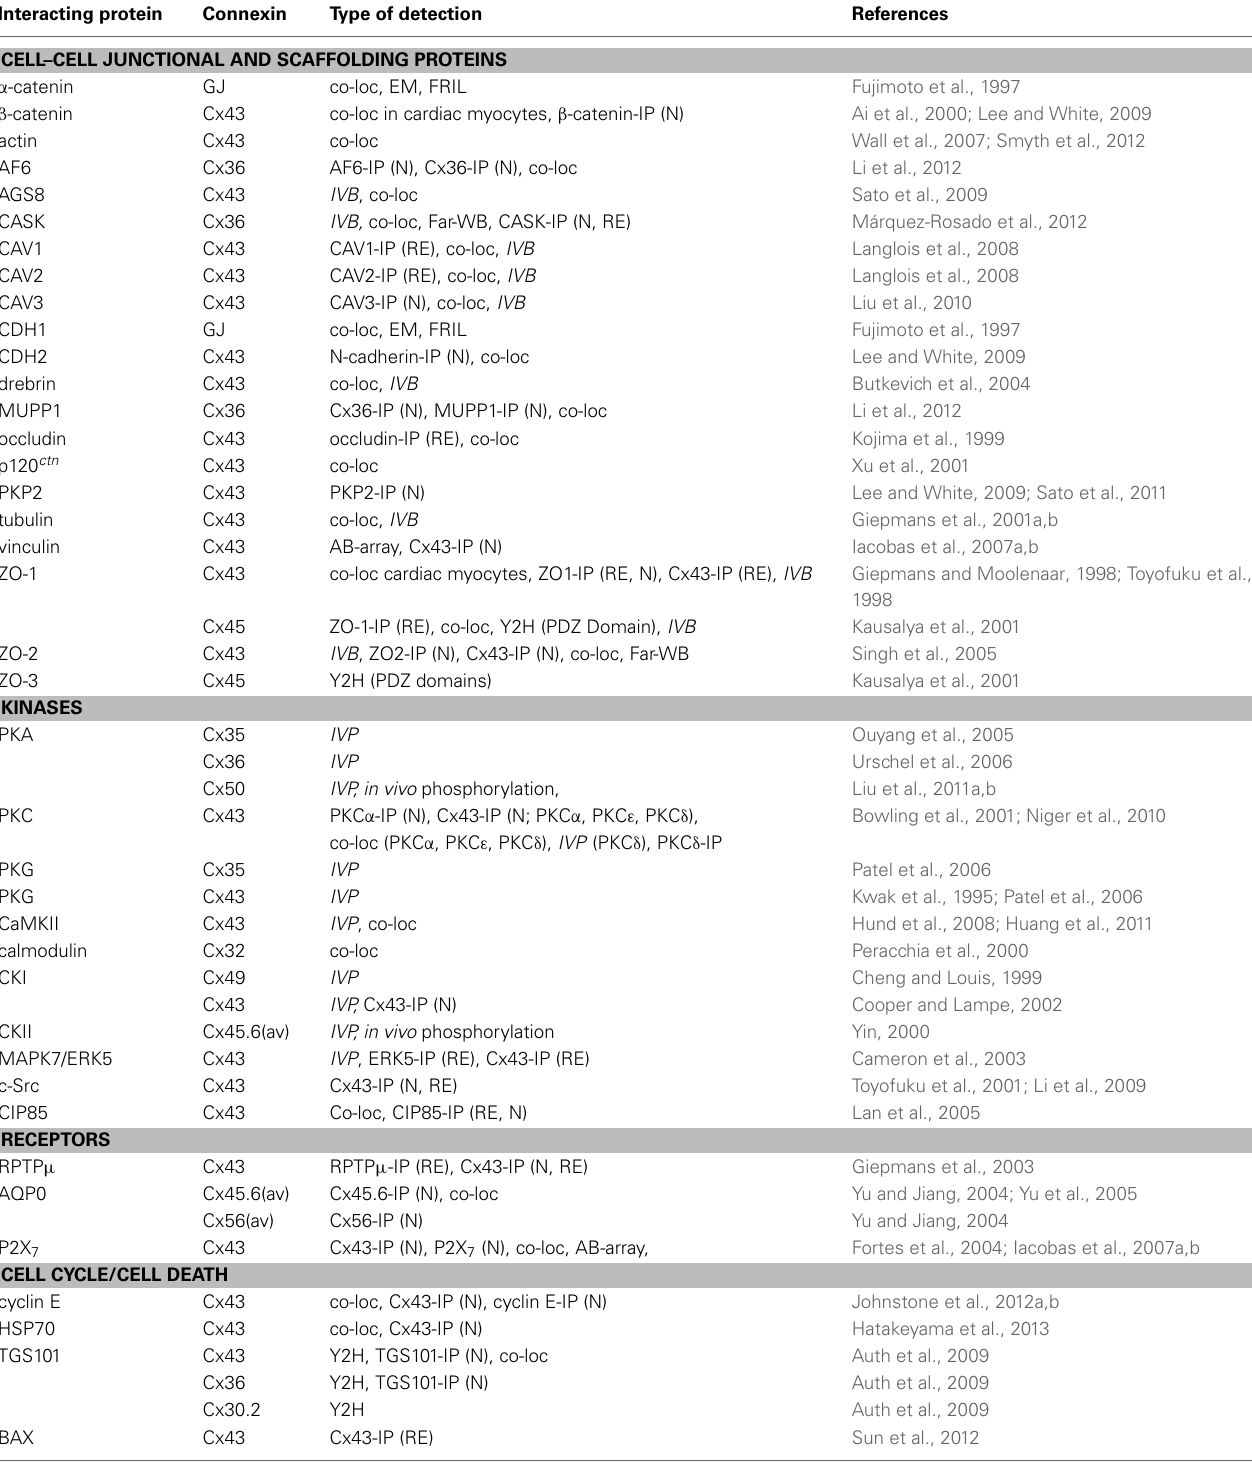
Summary of connexin interacting proteins. This table summarizes documented interactions described in the text and the detection methods used. It does not include indirect interactions with regulatory pathways. Abbreviations in alphabetic order: AB-array, antibody array; av, avian connexin; co-loc, co-localization in cells or tissues; IVB, in vitro binding, binding of peptides or functional domains; Far-WB, Far western blot; IVP, in vitro phosphorylation; N, native, non-transfected tissues, cells, or cell lines; RE, one or both IP partners were expressed in recombinant cells; Y2H, yeast two hybrid